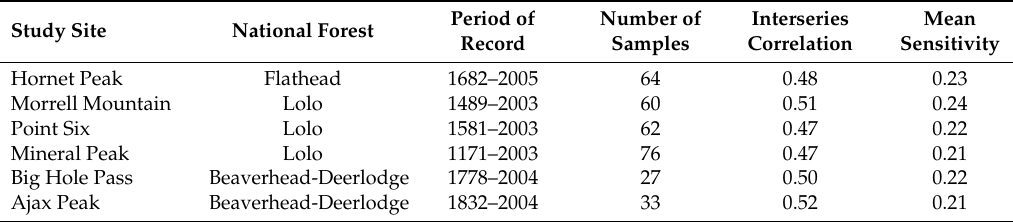
Table 2. Whitebark pine chronology information from six sites in western Montana.